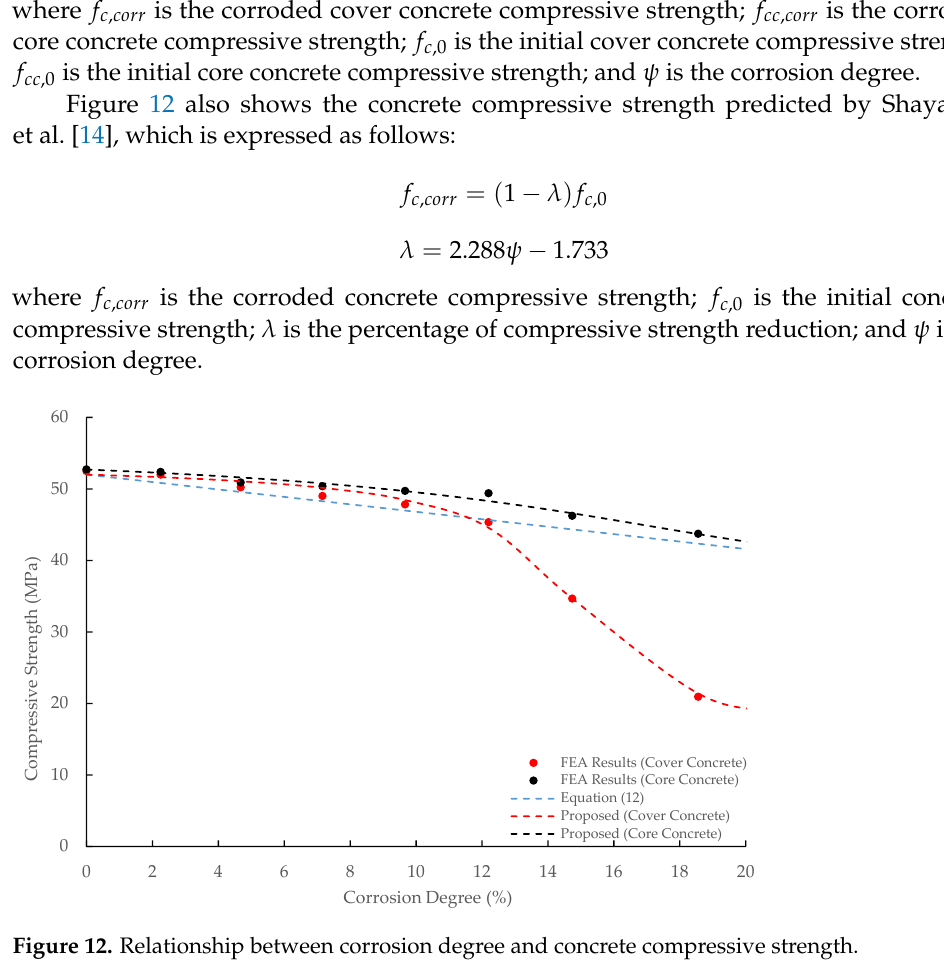
Figure 12. Relationship between corrosion degree and concrete compressive strength.